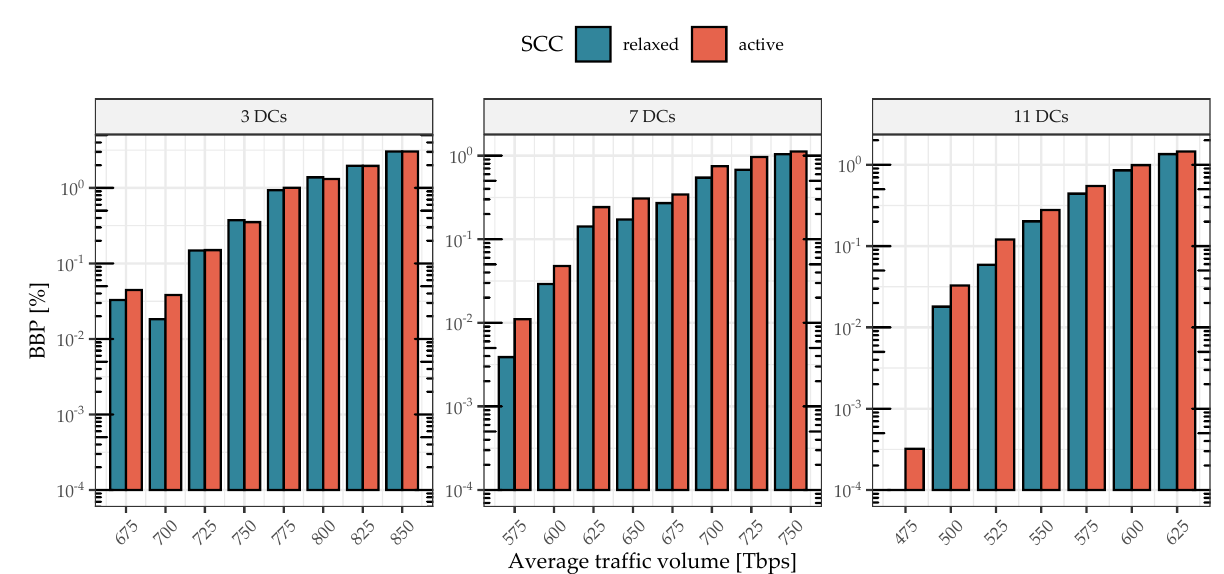
Figure 7. BBP as a function of average traffic volume for the SCC relaxed and active, for the FragA-TG